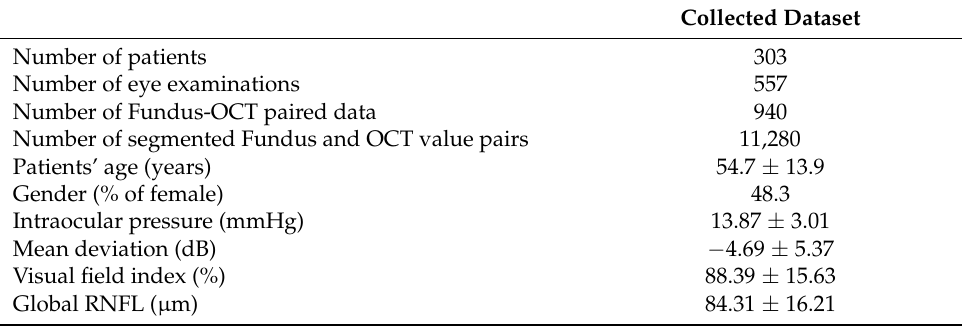
Table 1. Summary of dataset acquired from the NTG patients for the